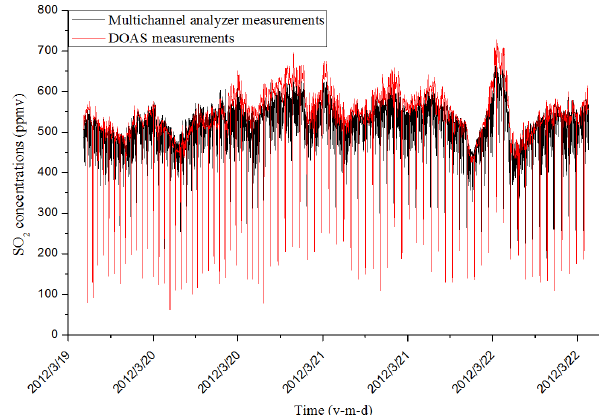
Figure 15. SO 2 concentrations time series of Wan power plant mea- sured with the DOAS analyzer and the multichannel analyzer during 18 to 27 March 2012. Measurements acquired during the blowback period are included, appearing as sharp dips of the concentration at fixed intervals.